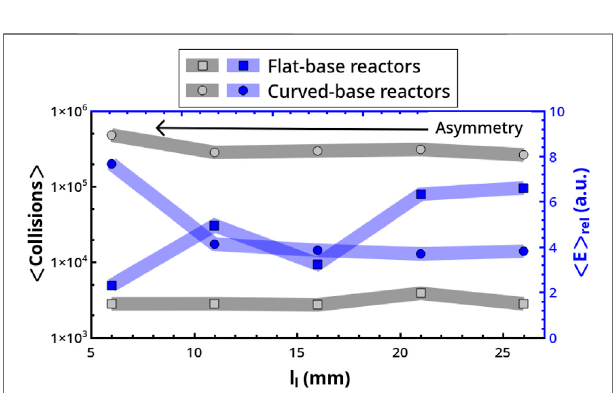
FIGURE 11 | Dependence of 〈 Collisions 〉 and 〈 E 〉 rel on the forcing asymmetry as controlled by the mechanical arm location, l l .